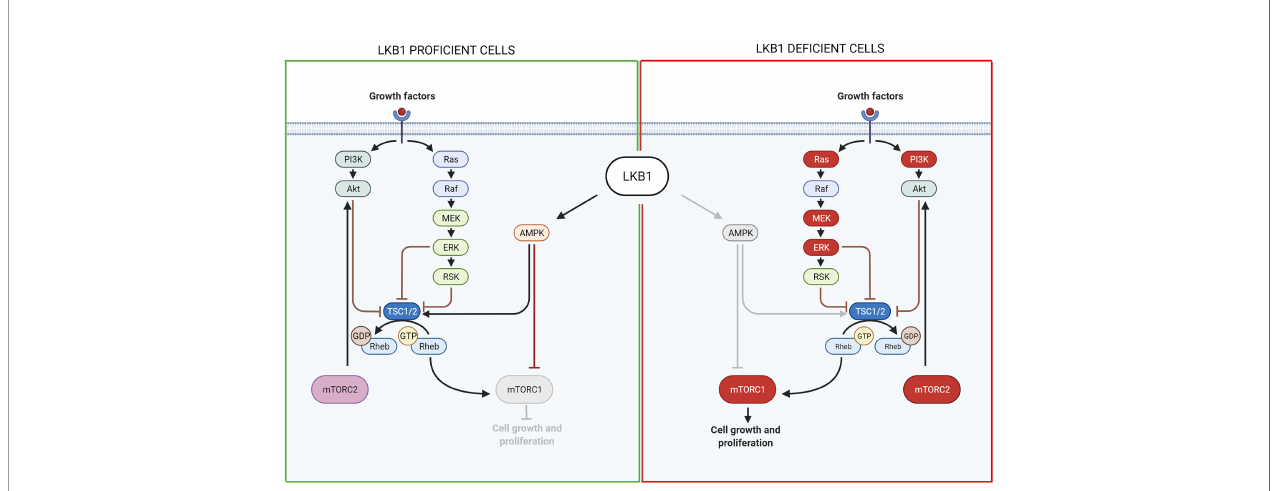
FIGURE 2 | Scheme of LKB1 downstream pathways involved in cell growth and proliferation and possible targets for pharmacological inhibition of LKB1 -mutated tumors. On the left, it is shown the pathway in LKB1-pro fi cient cells, while on the right in LKB1-de fi cient cells. Grey lines and grey circle indicate the inactivation of that way. The red circle proteins on the right show the possible targets for a pharmacological inhibition of LKB1 -mutated NSCLC growth and proliferation. Created with